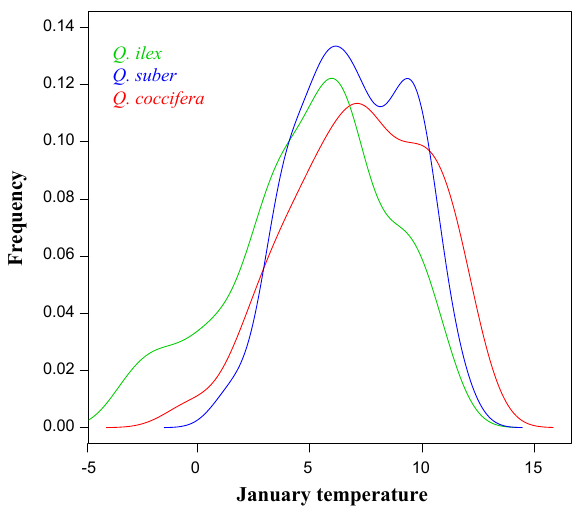
Figure 4. Density plots of T jan for the three dominating Quercus species in Morocco ( Q. ilex , Q. coccifera , and Q. suber ). The me- dian values are as follow: Q. ilex – 6.5 ◦ C; Q. coccifera – 7.4 ◦ C; and Q. suber – 7 ◦ C.